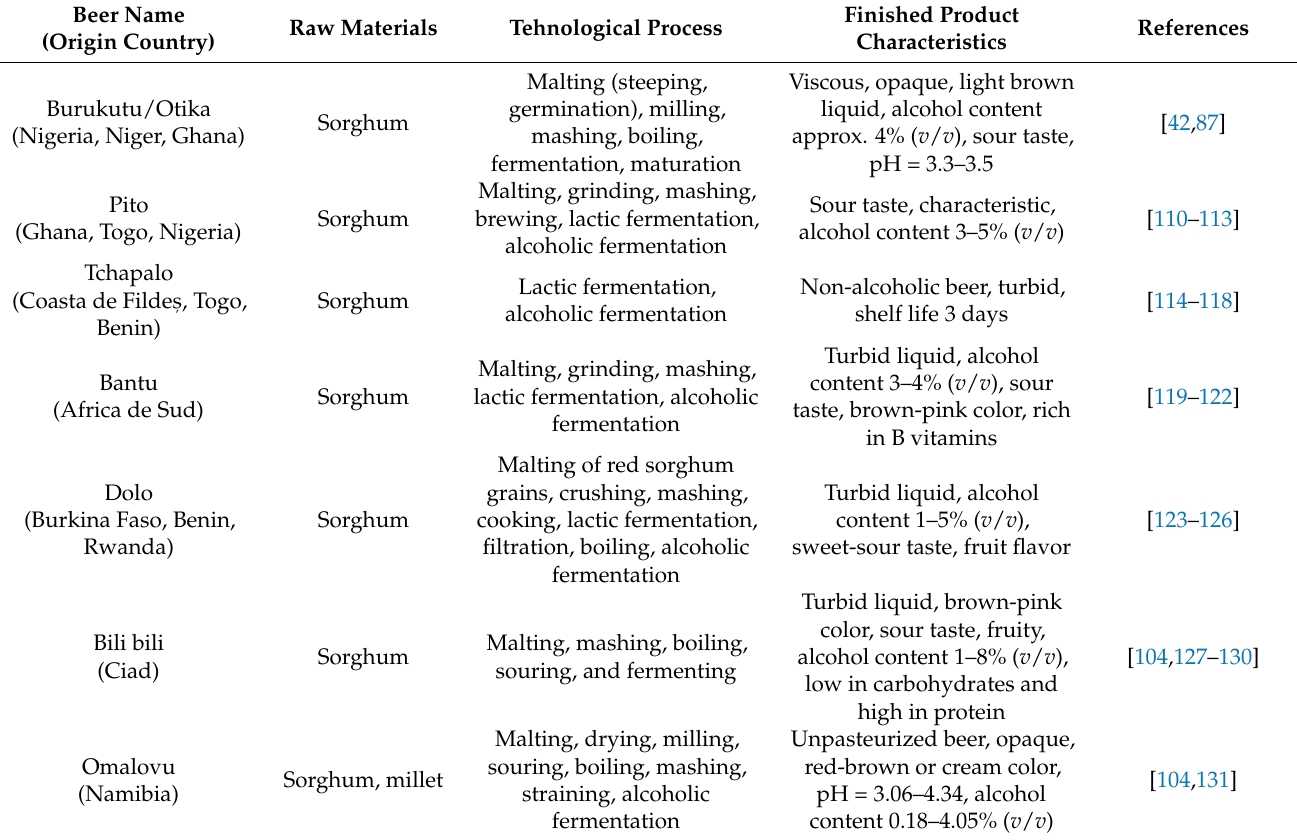
Table 3. Beer assortments in which sorghum is used as basic raw